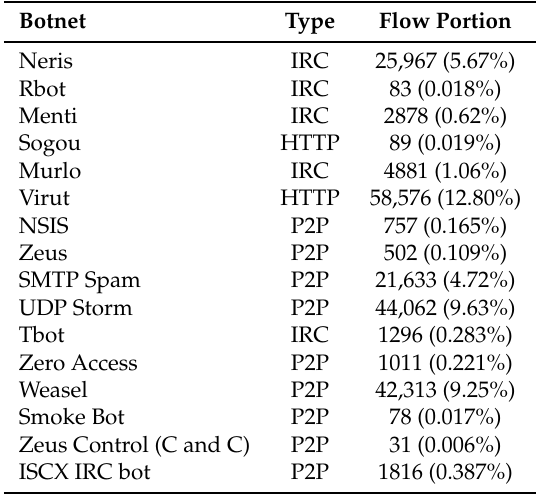
Table 1. Distribution of different botnets used in dataset.